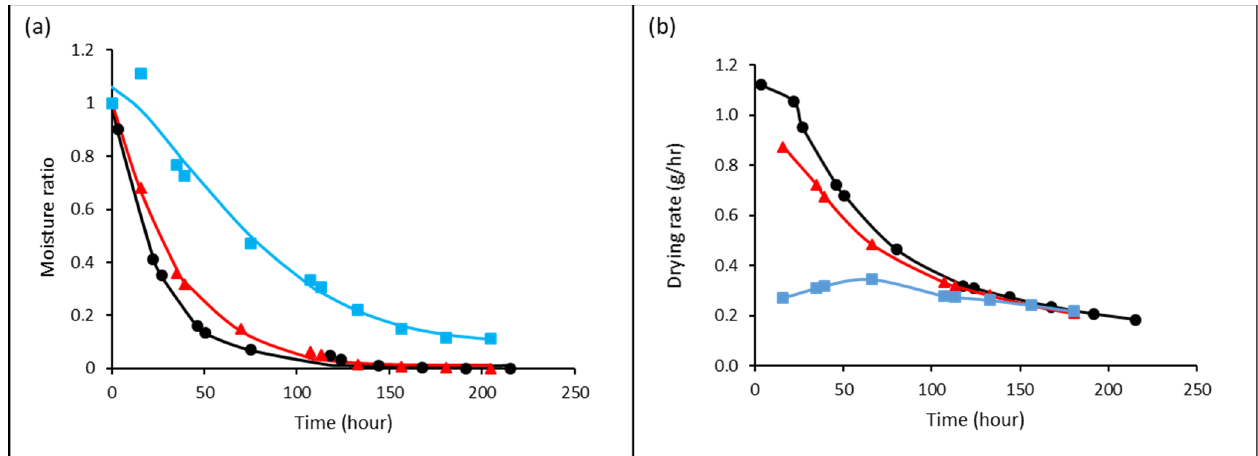
Figure 1. Thin-layer drying kinetic model (line) is well fitted to the experimental data of the moisture ratio of jaboticaba berries pretreated with 70% sugar ( ▲ ) and 10% salt ( ■ ) compared to berries